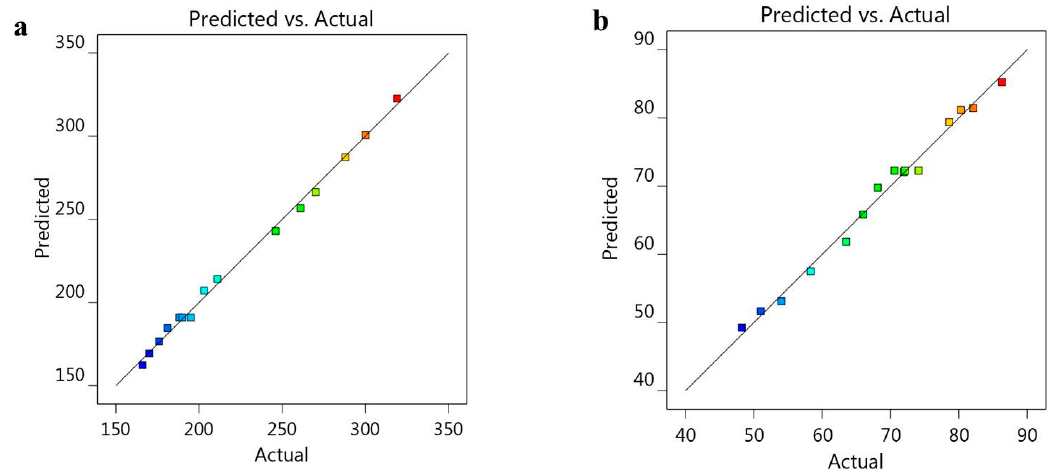
Figure 2. Linear correlation plot between predicted versus actual values representing the effect of the independent variables on ( a ) particle size R 1 , and ( b ) the in vitro release study R 2 .